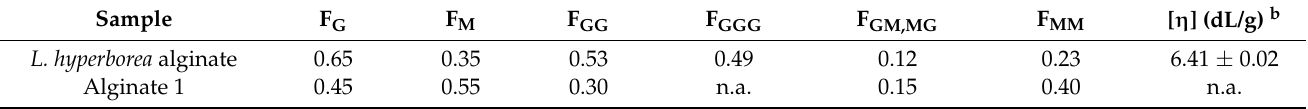
Table 3. Chemical composition and intrinsic viscosity of alginate from L. hyperborea a